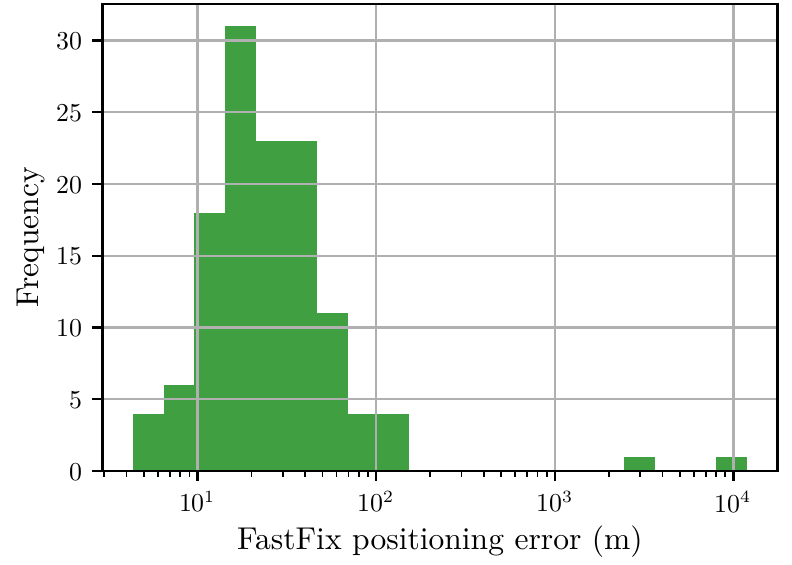
Figure 6. Histogram of horizontal fix errors (in meters). The median fix error is 27.7 m. The vertical axis represents the number of fixes that fall within the corresponding range of positioning